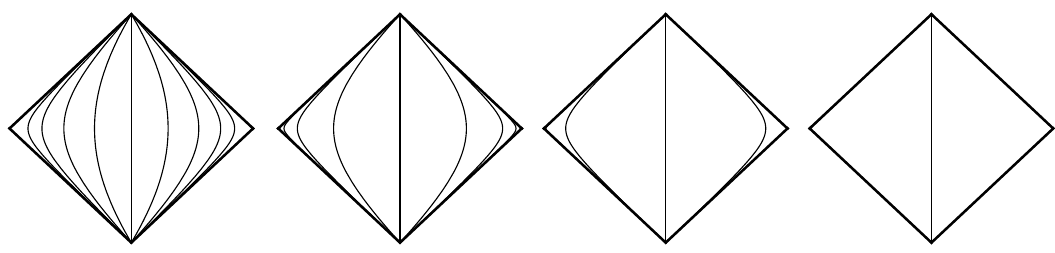
Figure 6. The curves (4.39) describing the modular evolution of D ( x ), in the case where x is the midpoint of the interval, for L = 10, (cid:12) = 10 and ‘ = 1 ; 2 ; 8 ; 9 from left to right. As ‘ ! L , the non-locality tends to disappear and the modular evolution becomes time evolution, consistently with the fact that, in this limit, the modular Hamiltonian reduces to the dynamical Hamiltonian times (cid:12) .